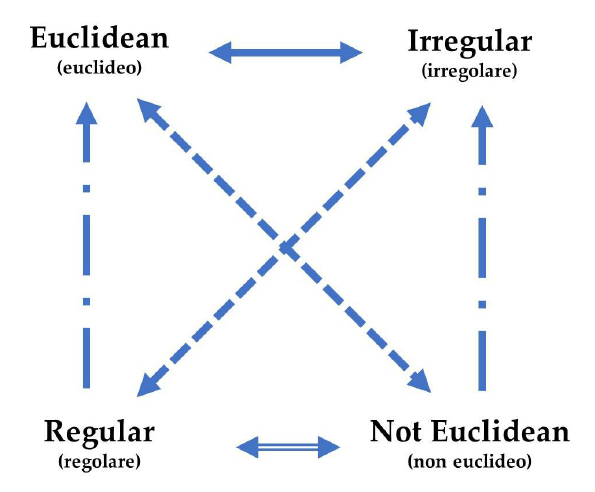
Figure 1. Greimas’s semiotic square related to the geometrical/mathematical aspects typical of Islamic